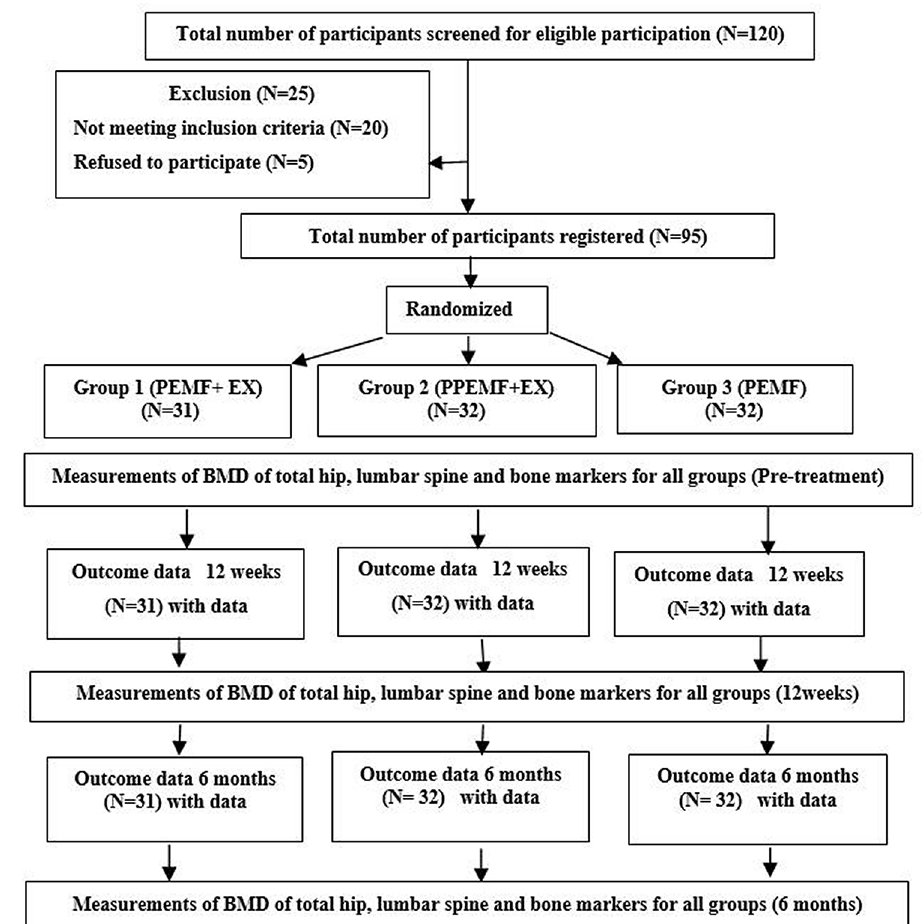
Figure 1. Flow chart of the study based on CONSORT